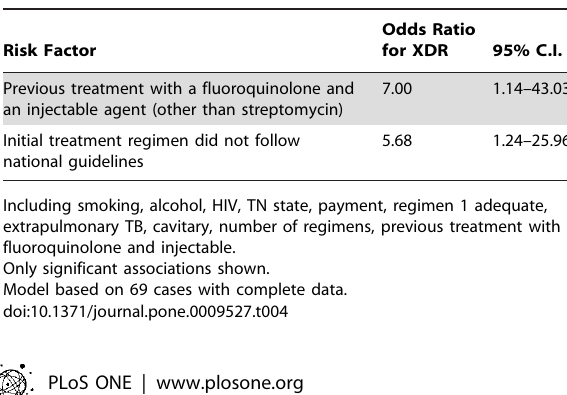
Odds Ratio for XDR 95%